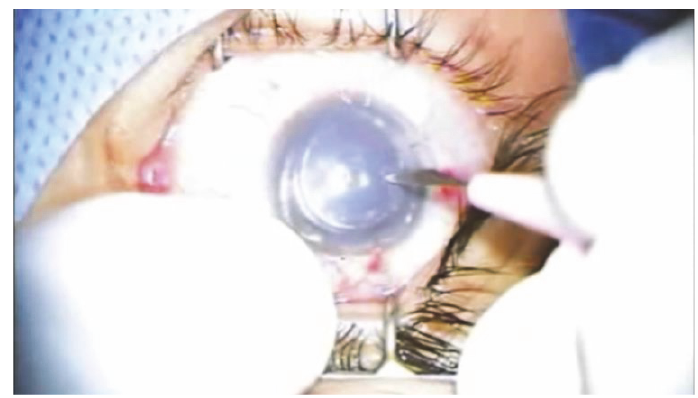
Figure 14: Venting performed to allow air to escape.